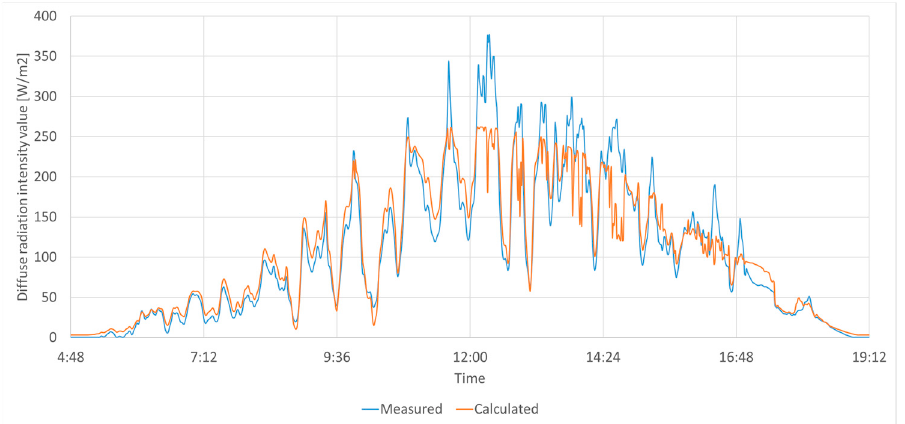
Figure 15. Compared scattered irradiance values measured and calculated using bivariate 3rd-order polynomial.